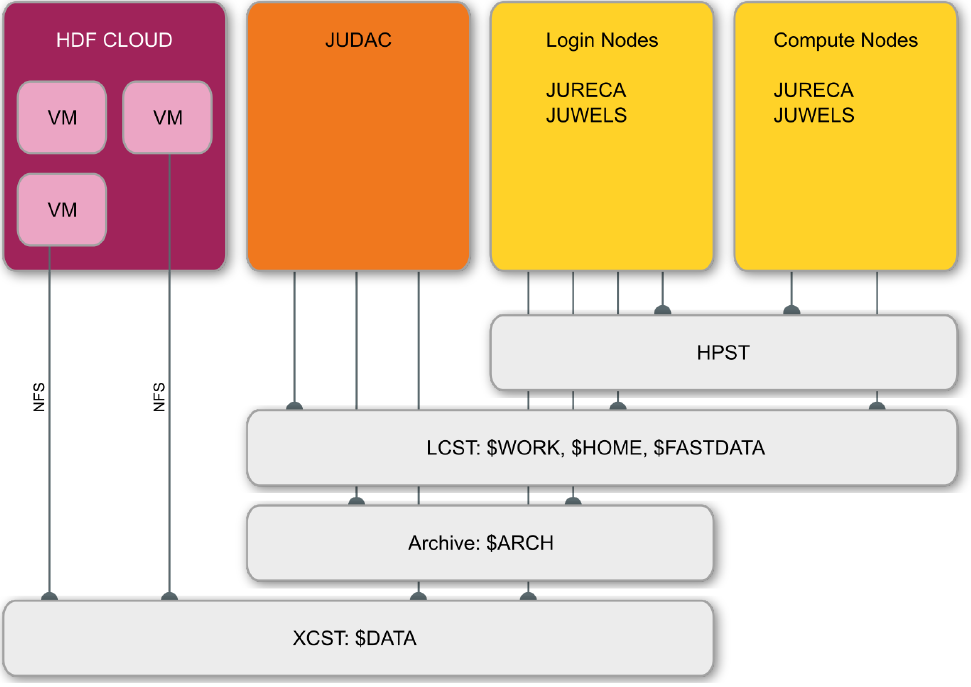
Figure 2: Access to storage tiers at Jülich Supercomputing